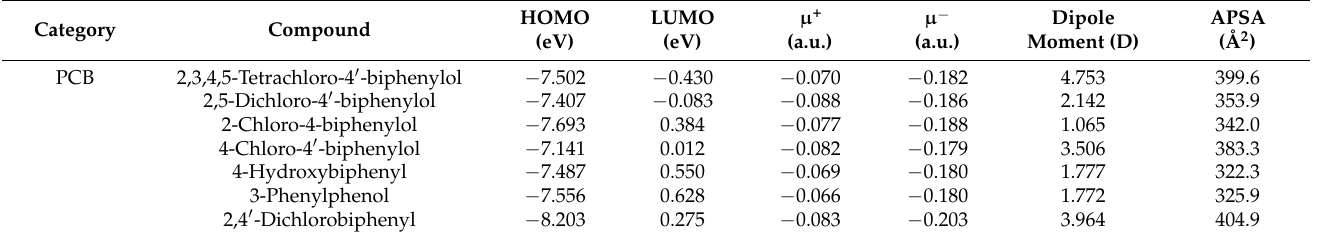
M06-2X/6-31G(d,p)/SCRF calculated descriptors for the quantum chemical GA- MLR